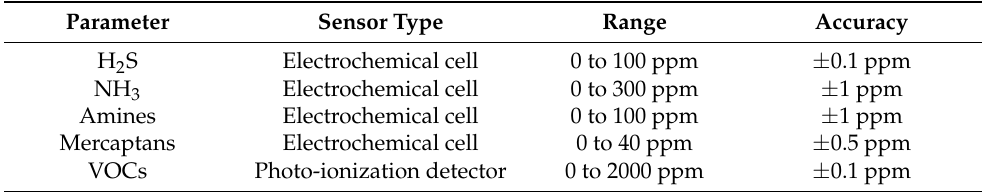
Table 2. Sensors included in the Dräger X-am 8000